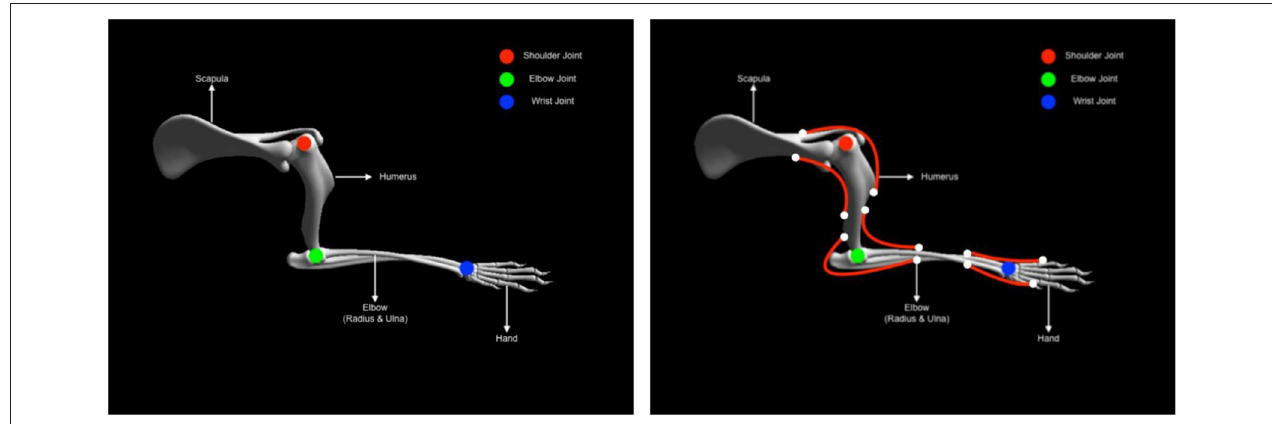
FIGURE 5 | Mouse forearm musculoskeletal system (left) Forelimb skeletal system with three joints (1) shoulder (Ball and socket) (2) elbow (hinge) (3) wrist (hinge). (right) Forelimb muscle system with six muscles (1) humerus-extension (2) humerus-flexion (1) elbow-extension (2) elbow-flexion (1) hand-extension (2)